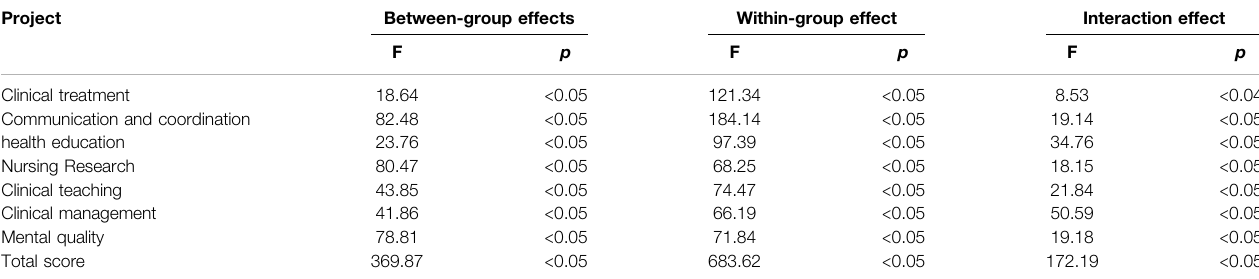
TABLE 6 | Repeated measures analysis of variance of two groups of clinical emergency ability score.